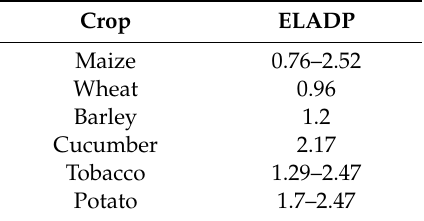
Table A1. Typical ELADP